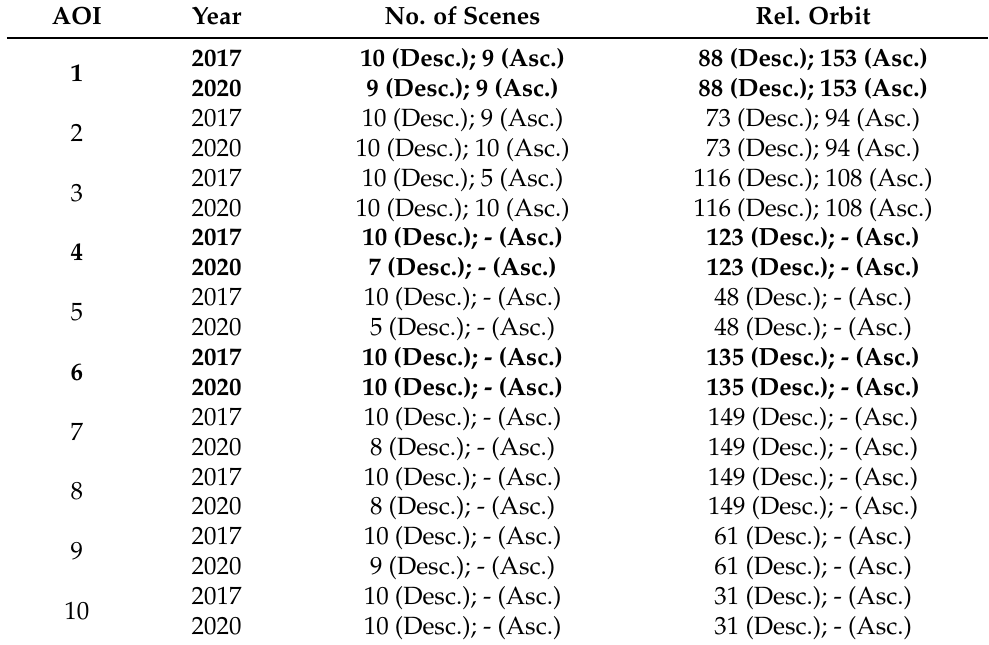
Table 2. Number of available Sentinel-1 (S1) Ground Range Detected (GRD) Interferometric Wide (IW) scenes per year and path direction after filtering the data to summer months (June–September) and further only selecting images from the most frequent relative orbit per aoi. Validation sites are marked in bold text. The minus symbol “-” represents no available